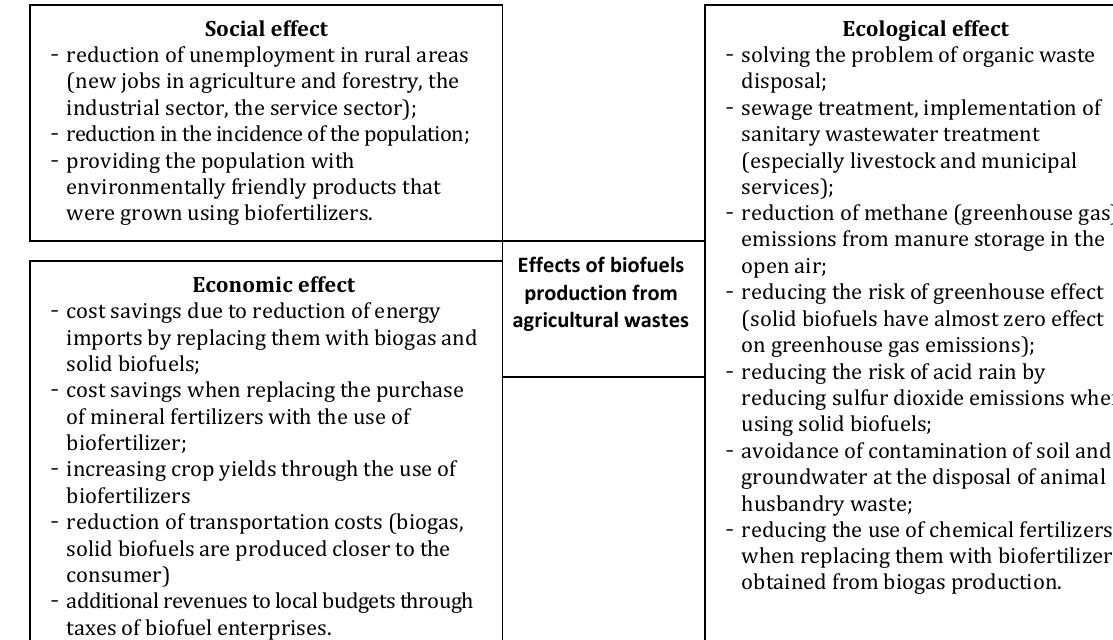
Fig. 4. Matrix of effects from the use of waste in the production of biofuels and their further use (Source: composed by the